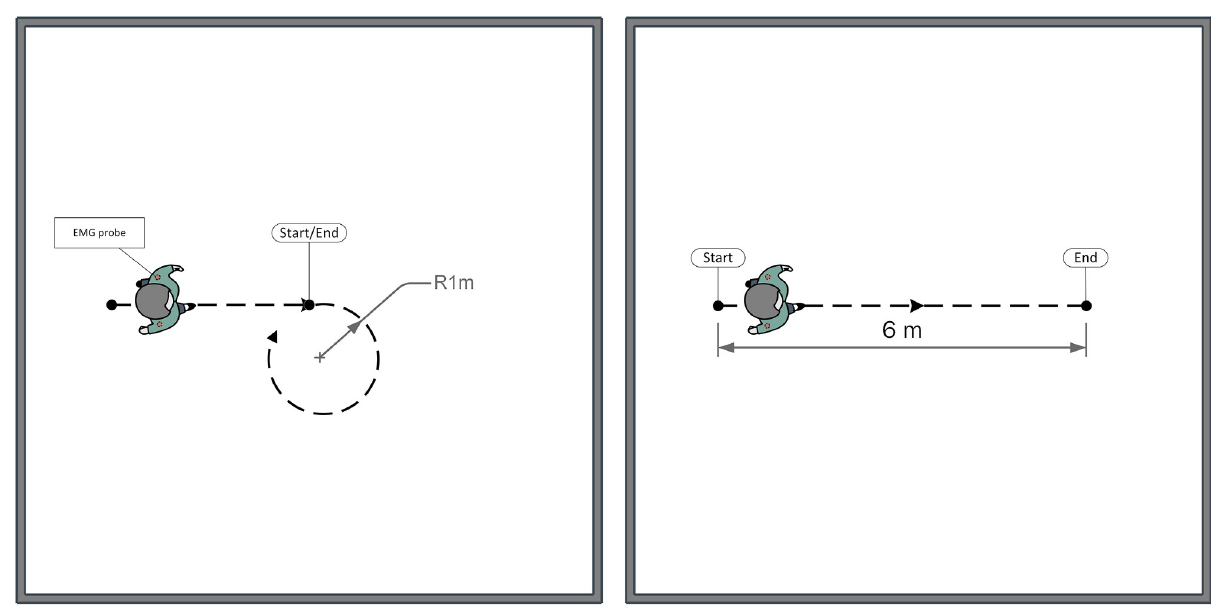
Fig 1. Experimental setup. Curvilinear task (left) and rectilinear task